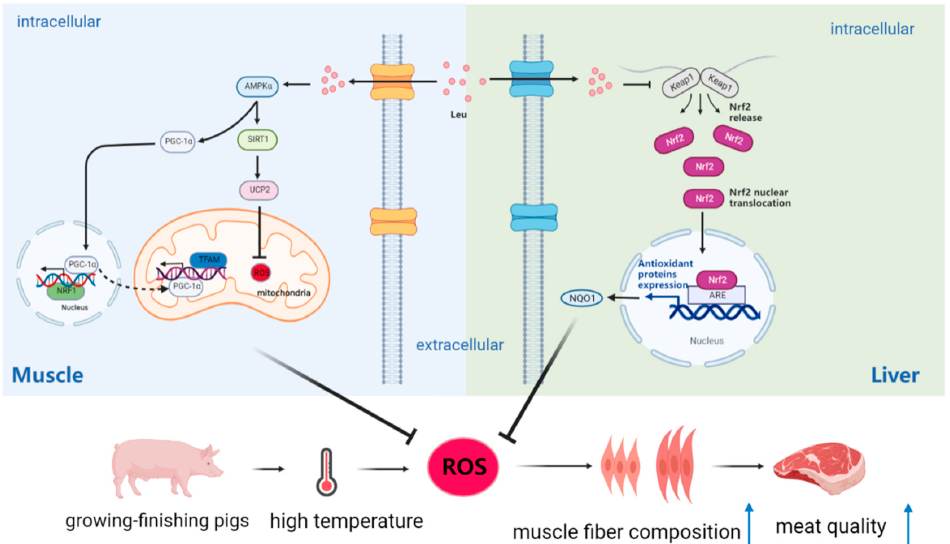
Figure 5. Mechanism of leucine regulating meat quality of finishing pigs under heat stress. Leucine enters muscle cells and activates the gene expression levels of AMPK α , AMPK α activates the expression level of SIRT1, which then activates the expression of UCP2, thereby inhibiting the production of mitochondrial ROS. In addition, AMPK also activates PGC-1 α , which entering the nucleus to promote the expression of NRF1 transferred to mitochondria to promote the expression of TFAM and improve the muscle injury caused by heat stress, then improve the meat quality. Leucine enters liver cells and promotes the separation of keap1-NRF2. When NRF2 is released, it was transferred to the nucleus and combined with ARE to activate the expression level of downstream NQO1 gene, inhibiting the production of ROS, and then alleviate the oxidative stress caused by high temperature, ultimately improving the meat